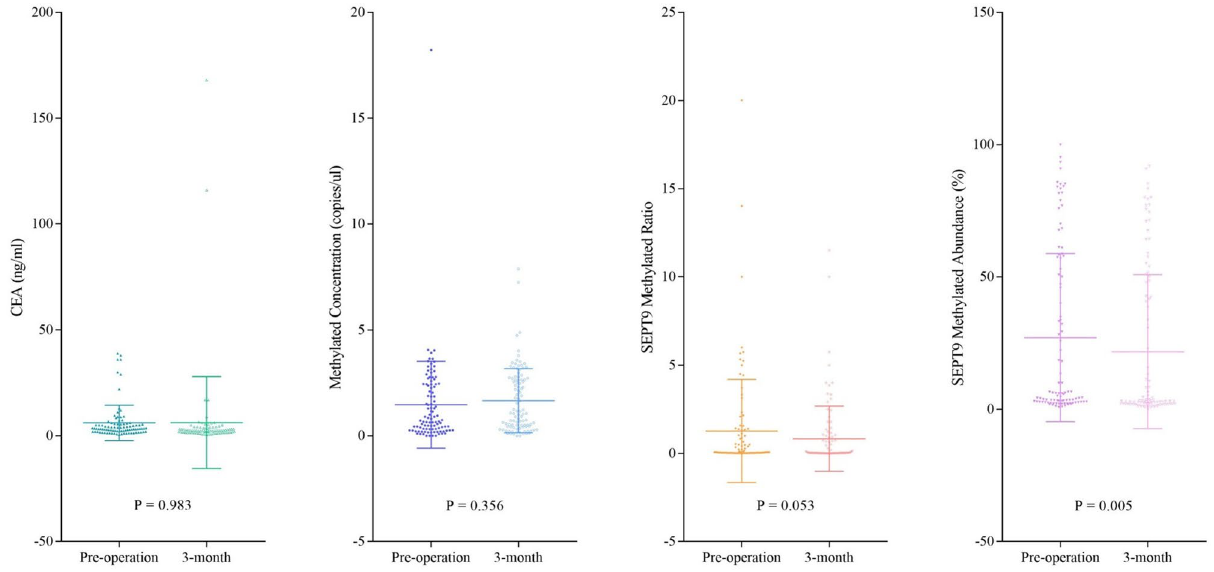
Figure 3. Changes in CEA and SEPT9 methylation levels at 3-month post-operation. This figure showed the changes of SEPT9 methylated status and CEA levels at 3-month after